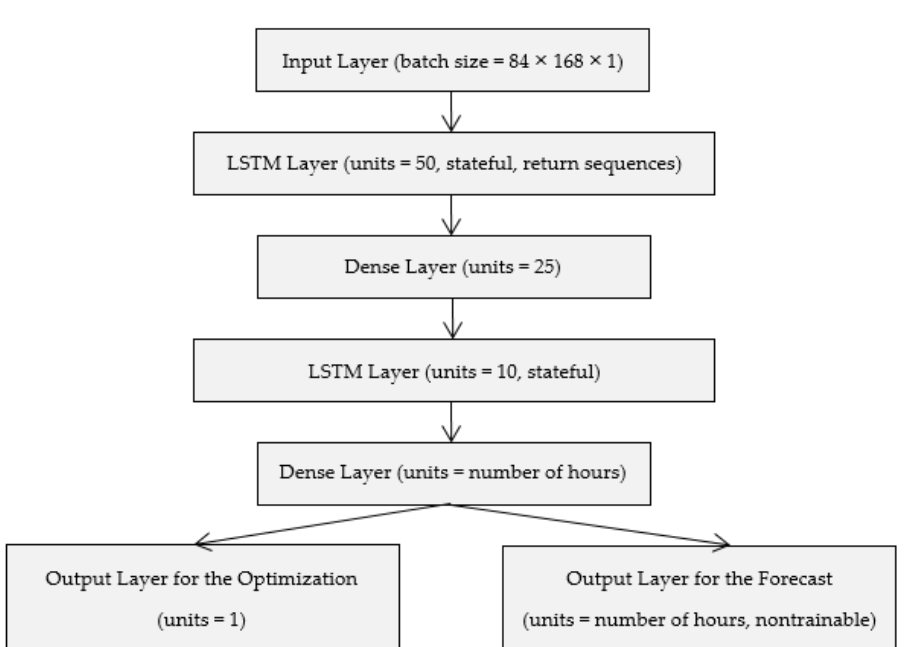
Figure 3. Hybrid model for optimization and multiple-output forecasting.